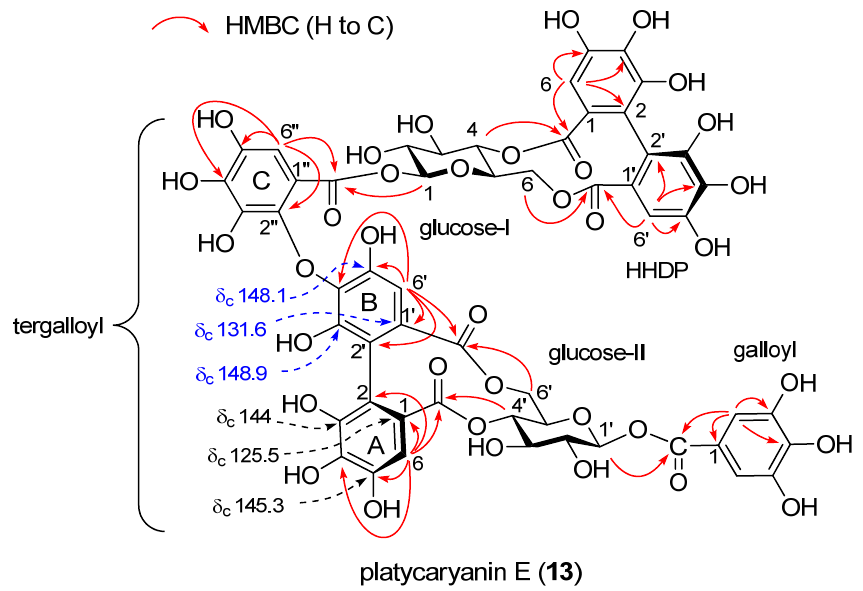
Figure 4. Selected NMR HMBC correlations and key 13 C NMR signals of platycaryanin E ( 13 ).